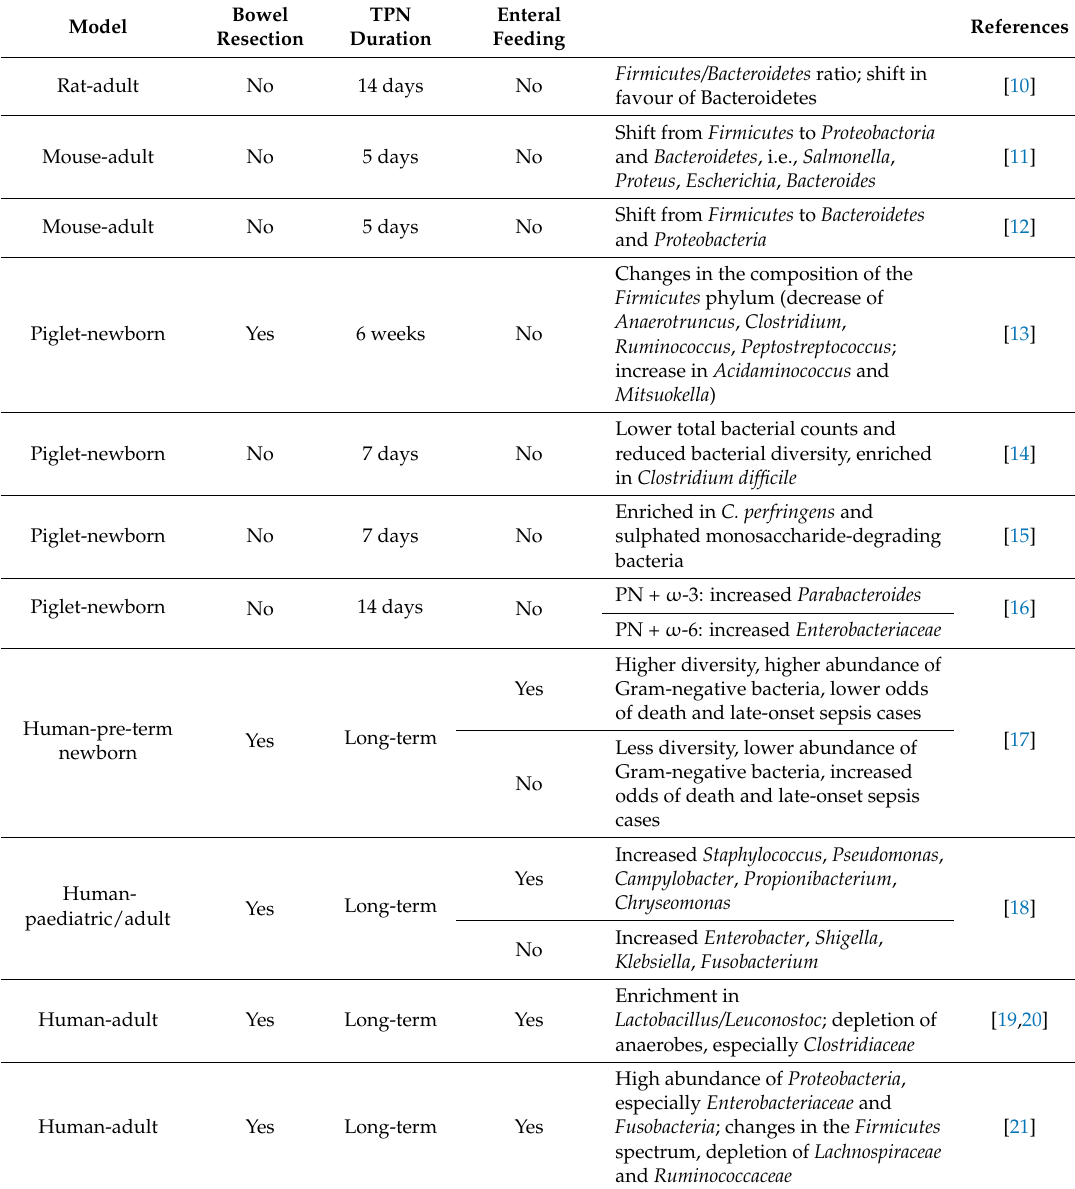
Table 1. The effect of parenteral nutrition on gut microbiome